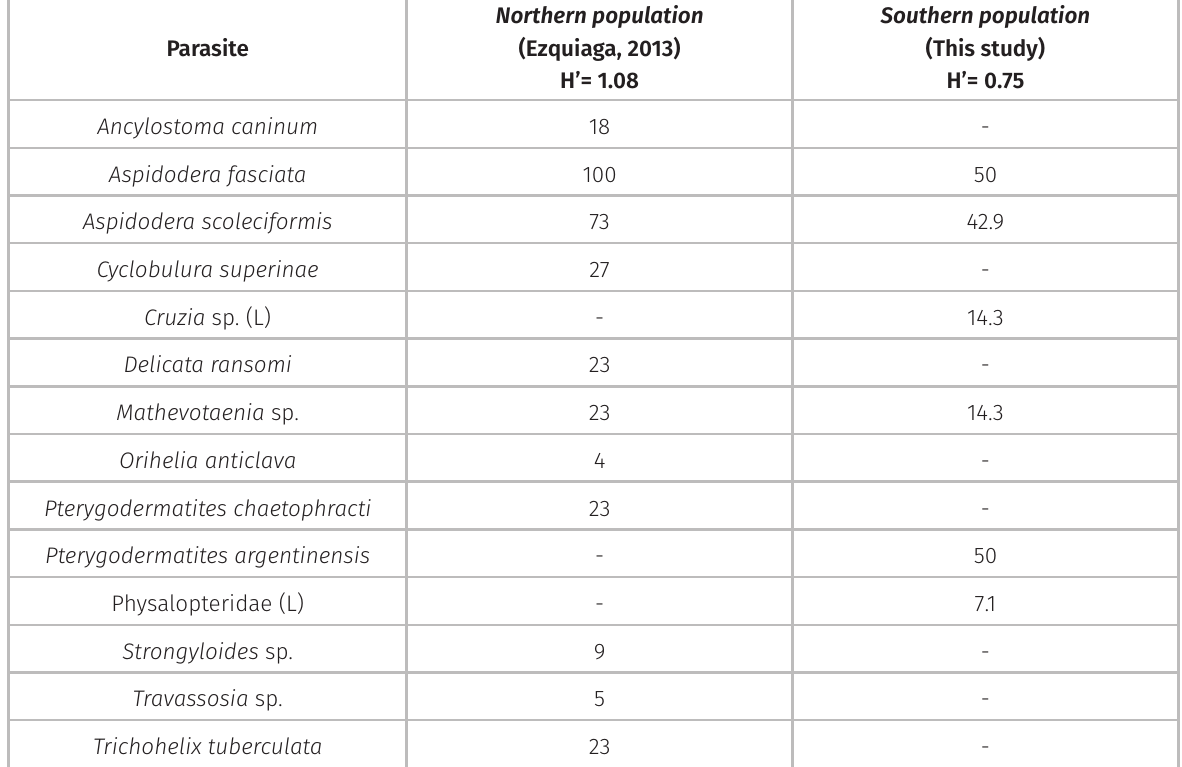
Table II. Helminths prevalence in Zaedyus pichiy northern and southern Patagonian population. H’= Shannon’s Diversity